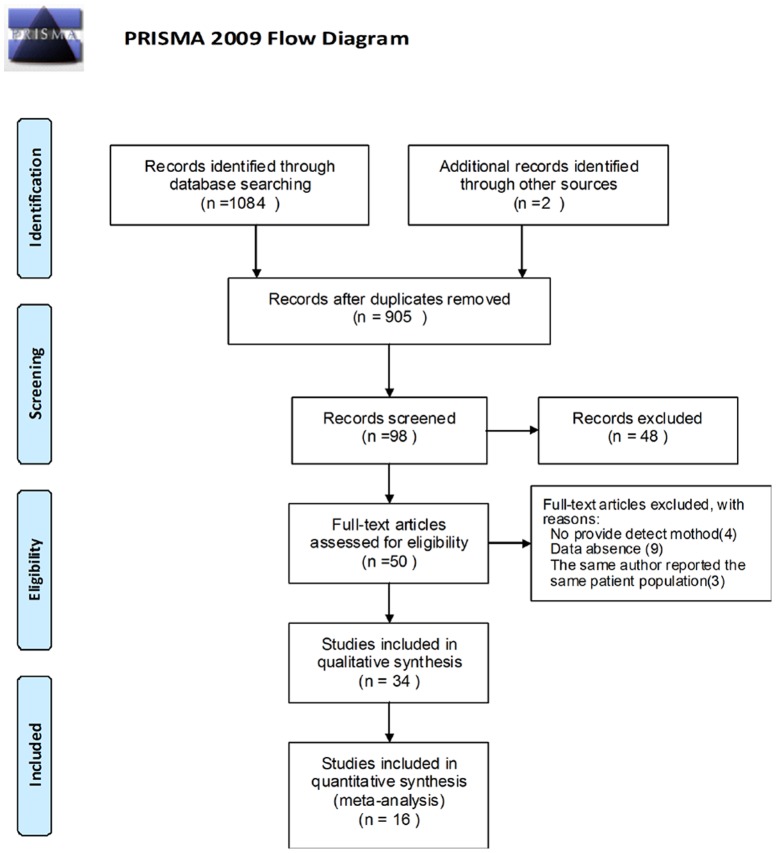
Flow chart of identified eligible studies.